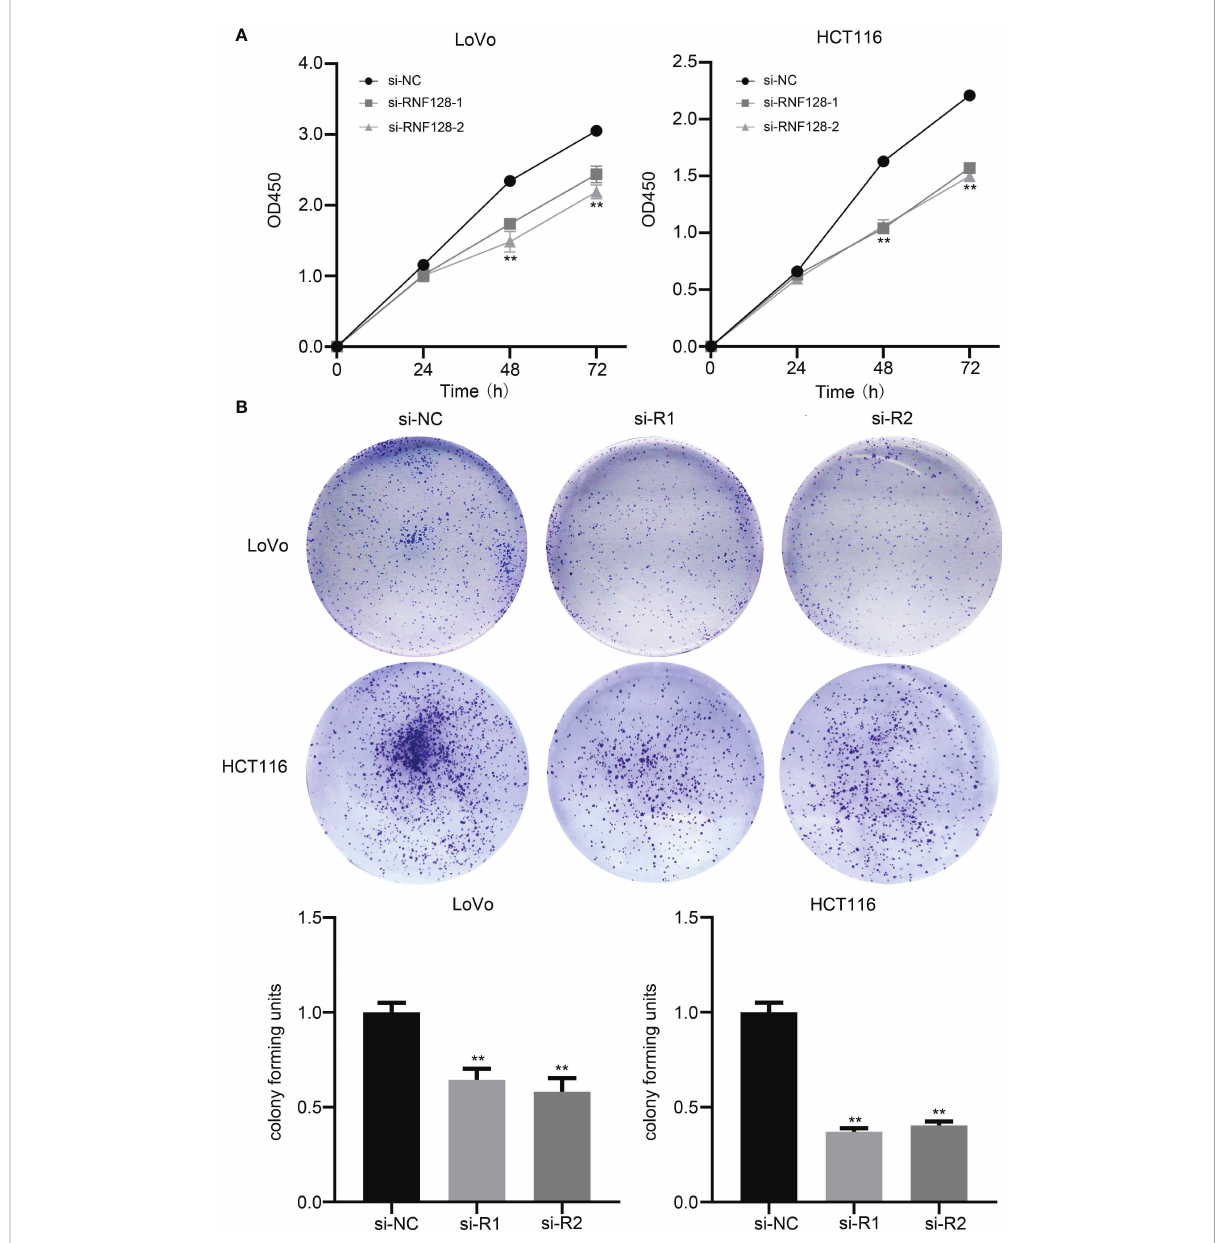
FIGURE 2 RNF128 promotes cell proliferation in colorectal cancer. (A) Cell proliferation was analyzed by CCK-8 assay, and cell viability was detected at 24, 48, and 72 h. LoVo and HCT116 cells were transfected with si-NC and si-RNF128. (B) Cell colony formation assays were used to observe the tumor formation ability of LoVo and HCT116 cells transfected with si-NC and si-RNF128. ** P